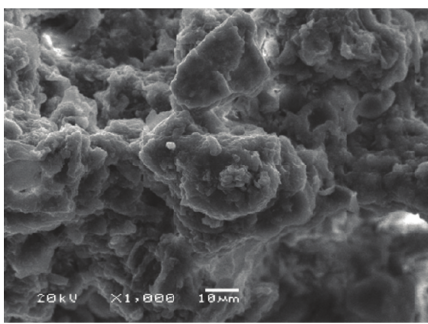
Figure 1: Electron micrograph of a vermicompost sample